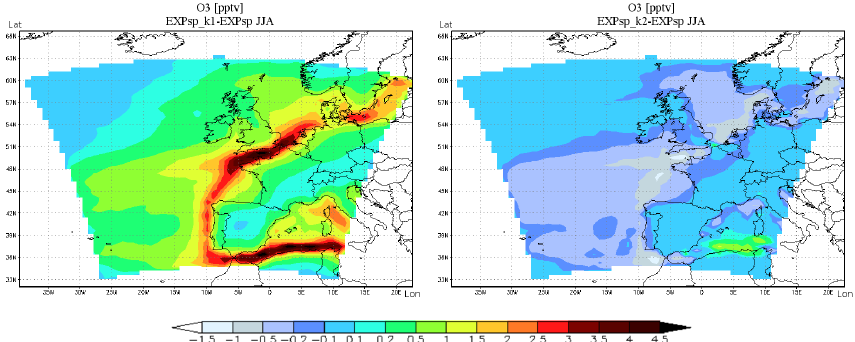
Fig. 10. Sensitivity test on the K eff parameter: difference of surface O 3 of experiments EXPsp k1 and EXPsp (left) and EXPsp k2 and EXPsp (right) in pptv, both for the summer